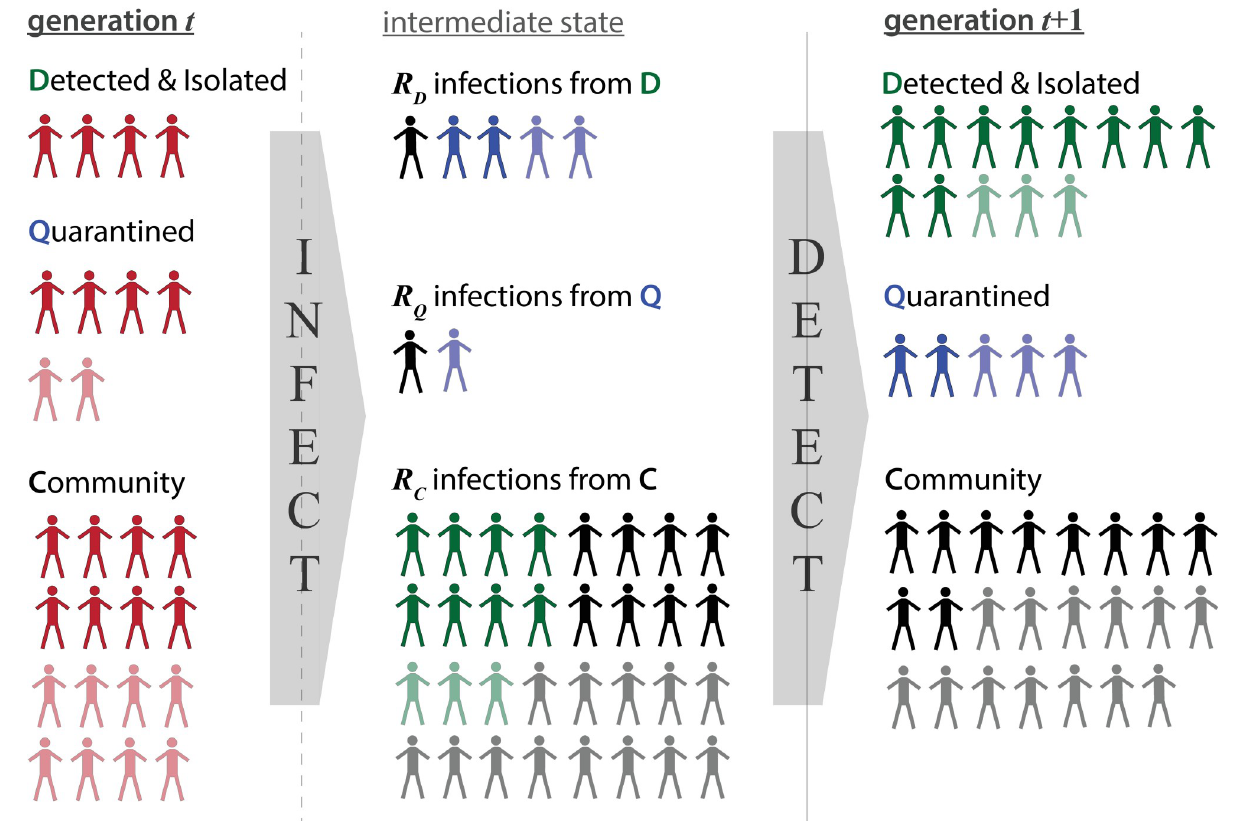
Fig 1. Conceptual representation of the model algorithm , where infections in generation t (left column) infect new individuals according to R and R C reproductive numbers that populate the INFECT matrix (center column). These newly propagated infections are then distributed into D , Q , and C compartments in generation t +1 (right column) according to the various detection transition probabilities specified in the DETECT matrix (colors of center column). Symptomatic individuals (darker shading) may be more likely to be detected than asymptomatic individuals (lighter shading ).